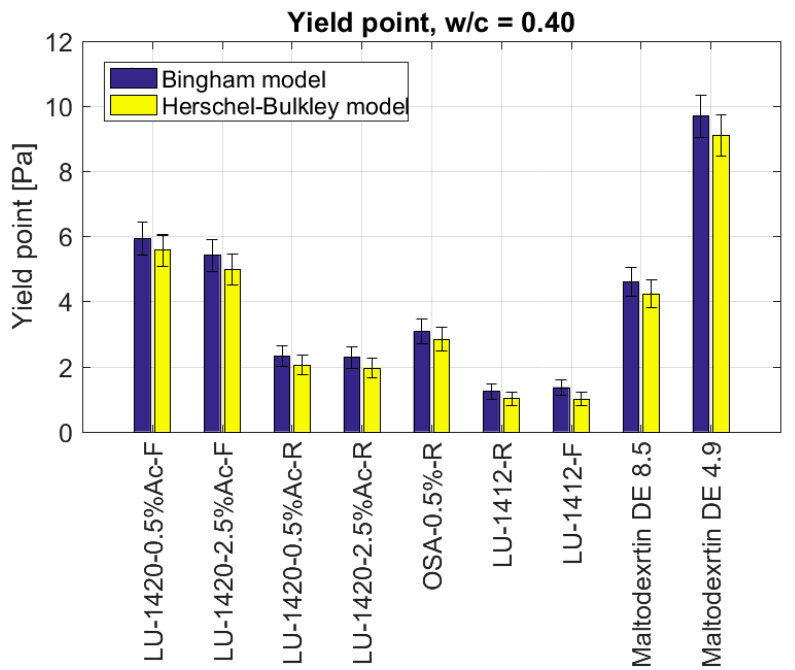
Figure 4. Yield points of cement slurries depending on the type of admixture in the form of modified starch for w/c = 0.40.